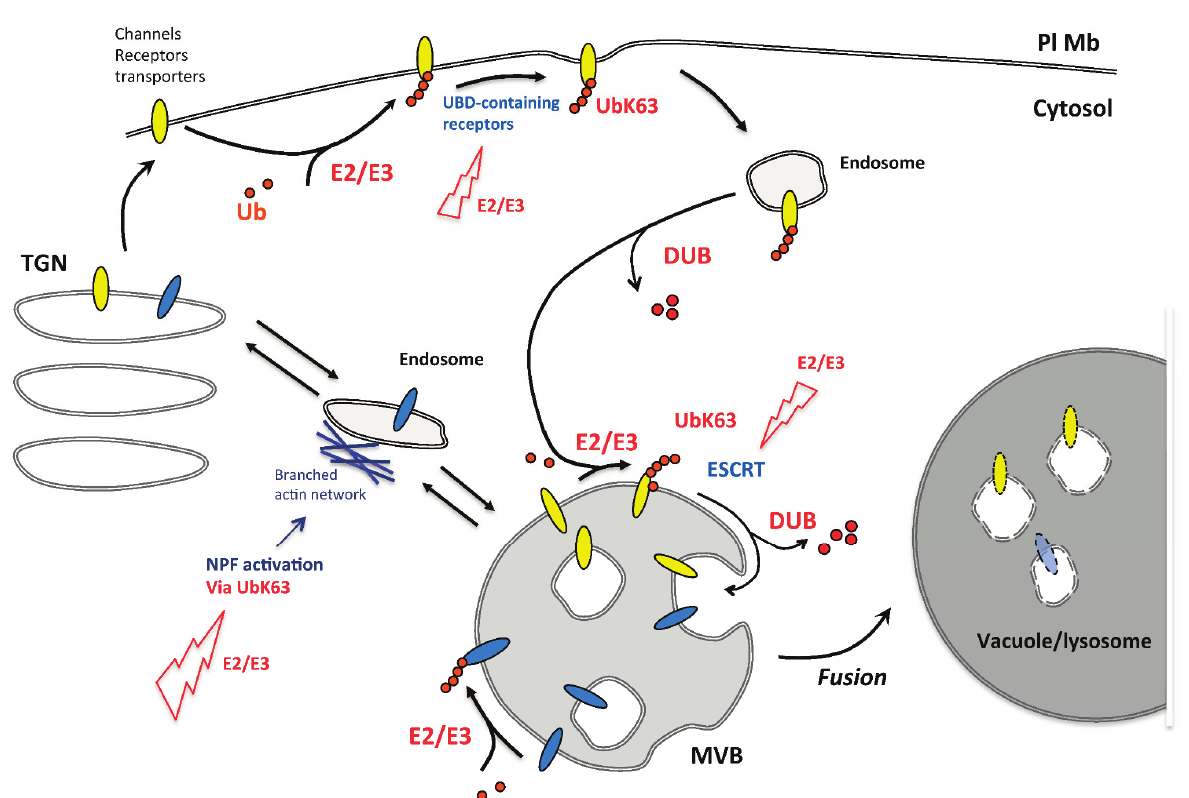
Figure 2. Examples of trafficking steps that involve UbK63